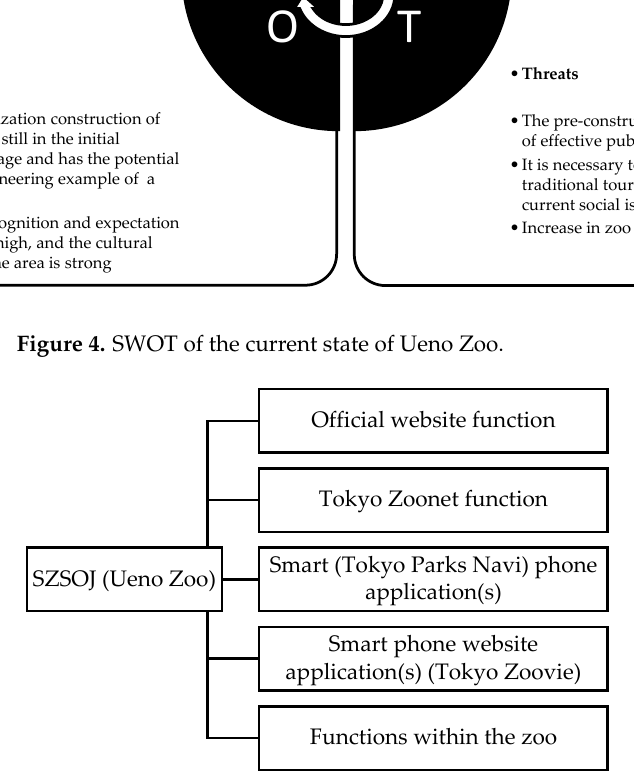
Figure 5. The framework system of the current state of Ueno Zoo.